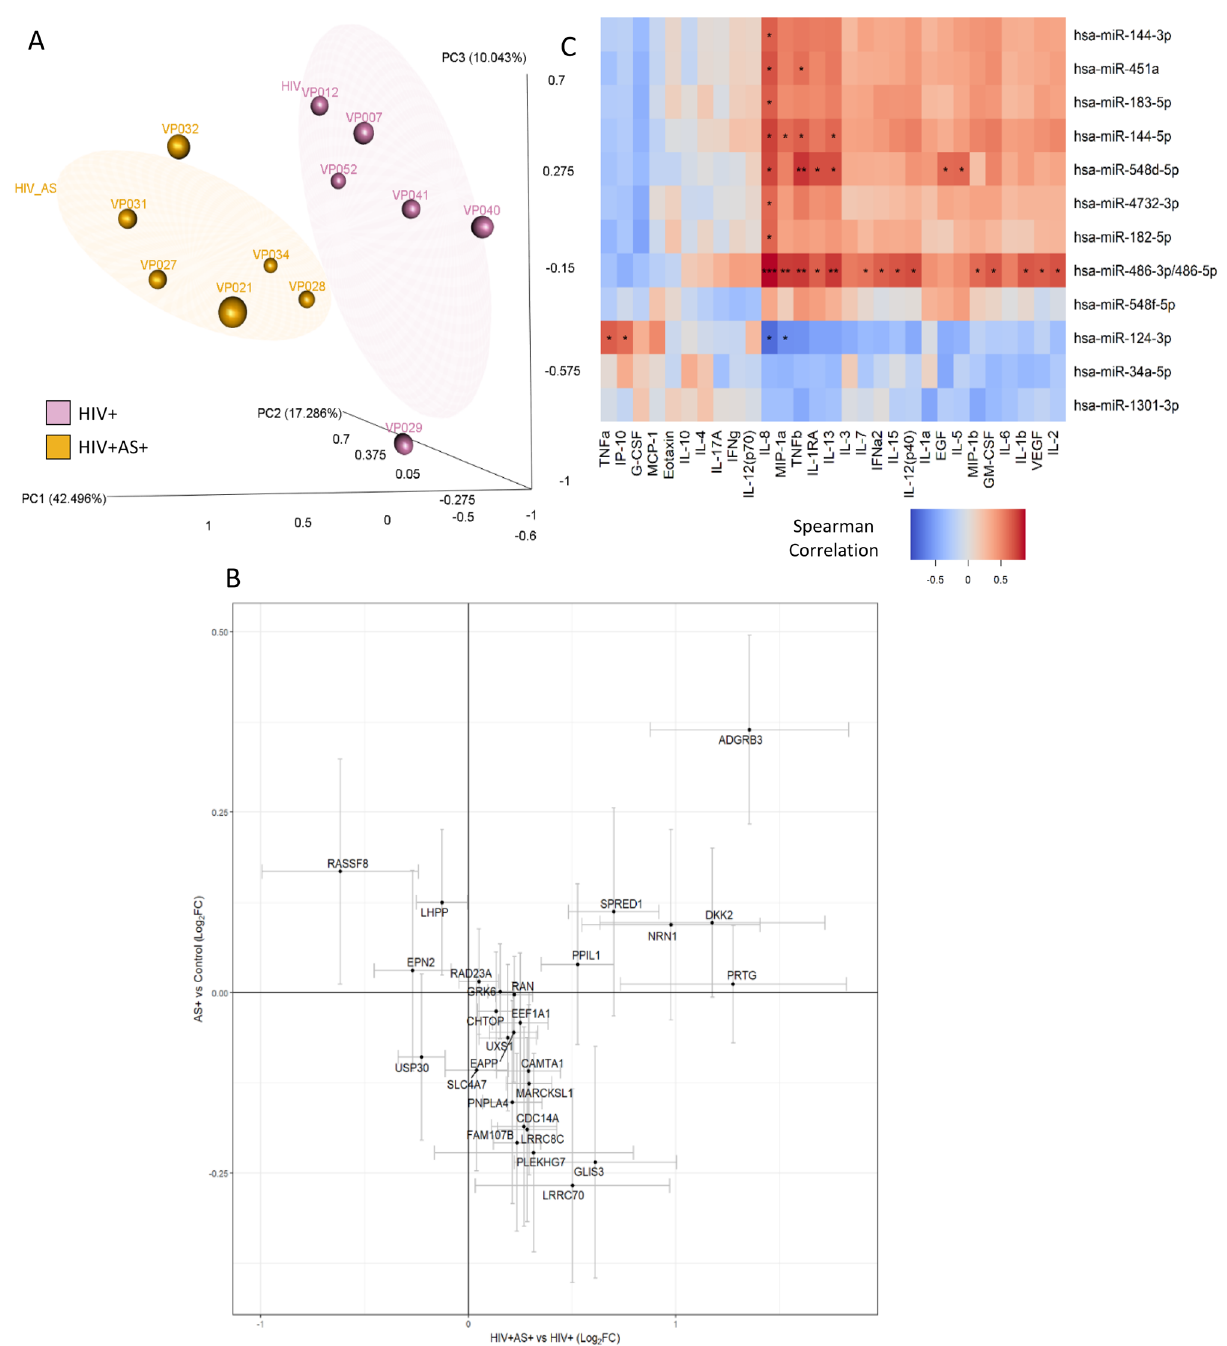
Figure 4. Interaction of miRNA expressed in PBMCs with mRNA expression in PBMCs and cytokines and chemokines levels in plasma: (A) miRNA target genes were identified using miRNAtap package 60 and were further filtered to keep only genes whose expression was negatively correlated with the expression of their regulator miRNA. The filtered genes were analyzed by Linear Discriminant Analysis (LDA) and 27 target genes were selected based on separation between AS+ (yellow)/− (purple) groups. PCA with 27 genes are shown (s). (B) Log2 fold change of HIV+ AS+ vs HIV+ and AS+ vs healthy control for 27 target genes. (C) Association of miRNA with cytokine and chemokines using the data from HIV+ AS+ and HIV+ AS− groups. Spearman correlation; significant associations are indicated with stars (*p-value < 0.05, **p-value < 0.005, ***p-value < 0.001). Analysis and graphical output done in R (ver 3.5.1) 57